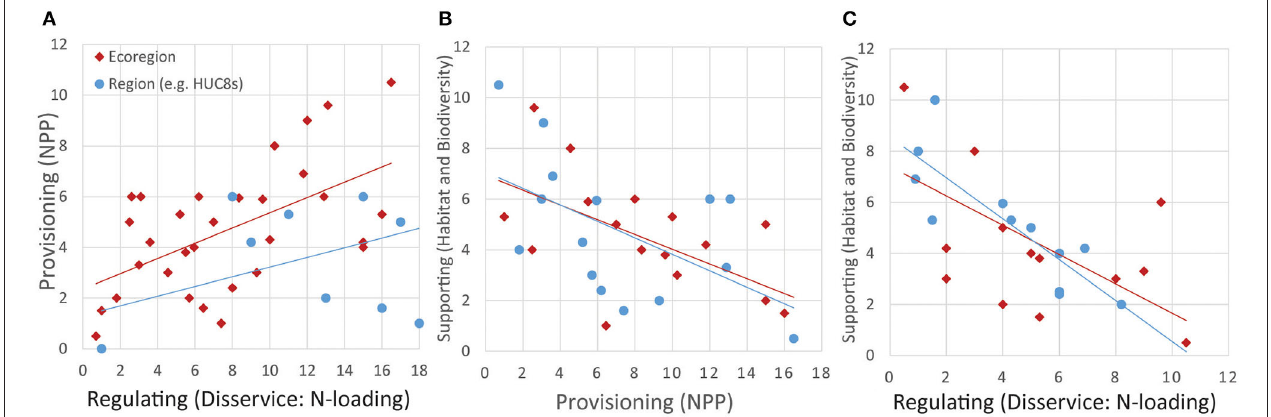
FIGURE 1 | Hypothesized relationships, displayed as scatterplots and linear trendlines, among provisioning, regulating and supporting ecosystem services in the southeastern US, at ecoregion and regional (e.g., HUC-8) scales. Regulating services are represented as a disservice, e.g., nitrogen (N) loading of aquatic systems. Provisioning services are represented as net primary production (NPP). Supporting services are represented as measures of habitat and biodiversity. Ecoregional values (in red) were simulated as a bivariate distribution, and regional values were a random selection of the ecoregion. (A) Hypothesized positive relationship between regulating (disservices) and provisioning services at ecoregional (red) and regional (blue) scales. (B) Hypothesized negative relationship between provisioning and supporting services at ecoregional (red) and regional (blue) scales. (C) Hypothesized negative relationship between regulating and supporting services at ecoregional (red) and regional (blue)